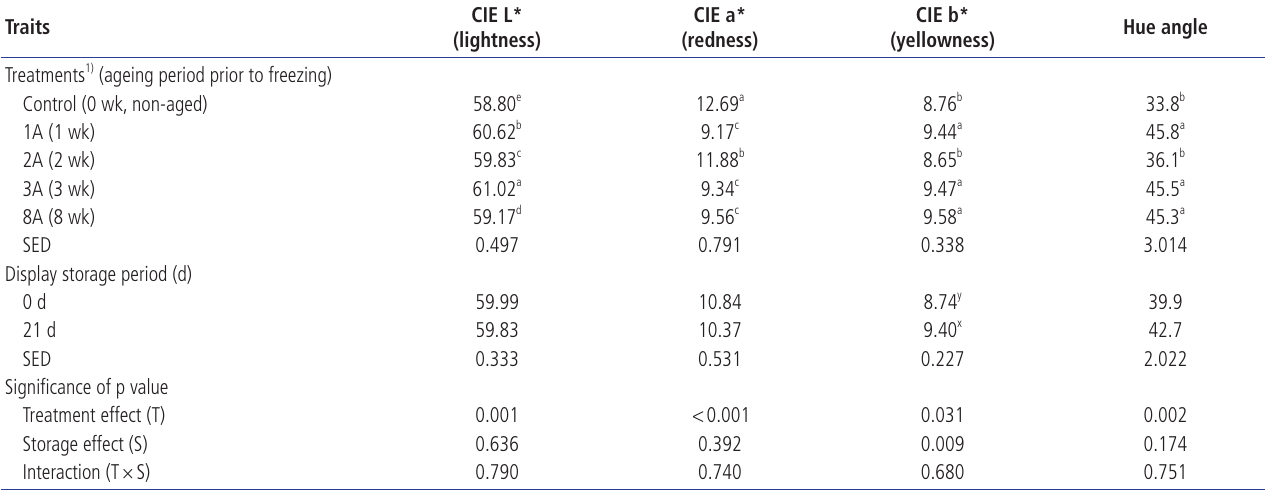
Table 5. Colour characteristics of cooked model sausages formulated with aged/frozen/thawed lamb loins on 0 and 21 d of display storage Traits Treatments 1) (ageing period prior to freezing) Control (0 wk, non-aged)